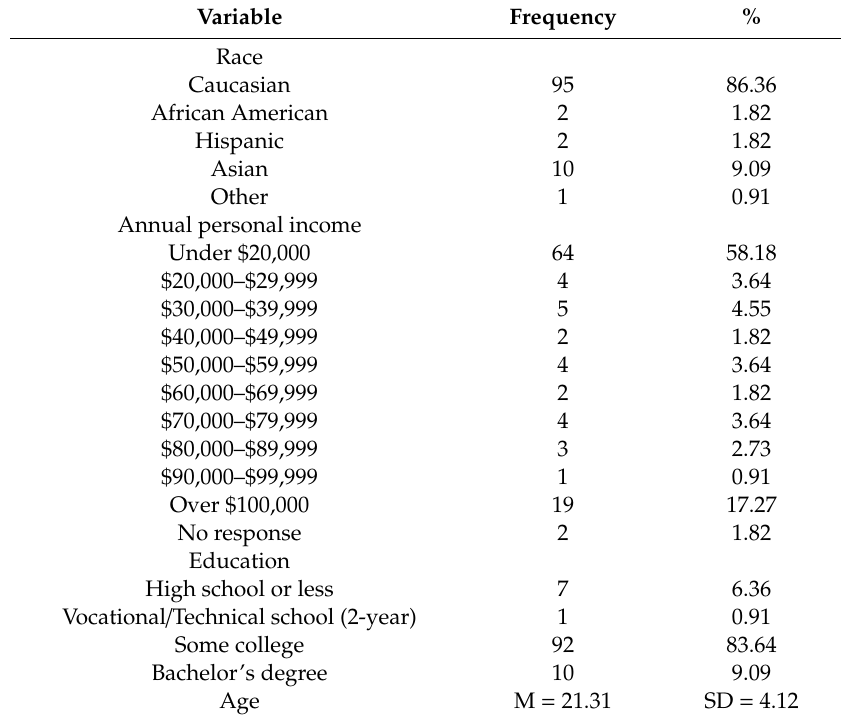
Table 1. Demographic summary of the sample (n =